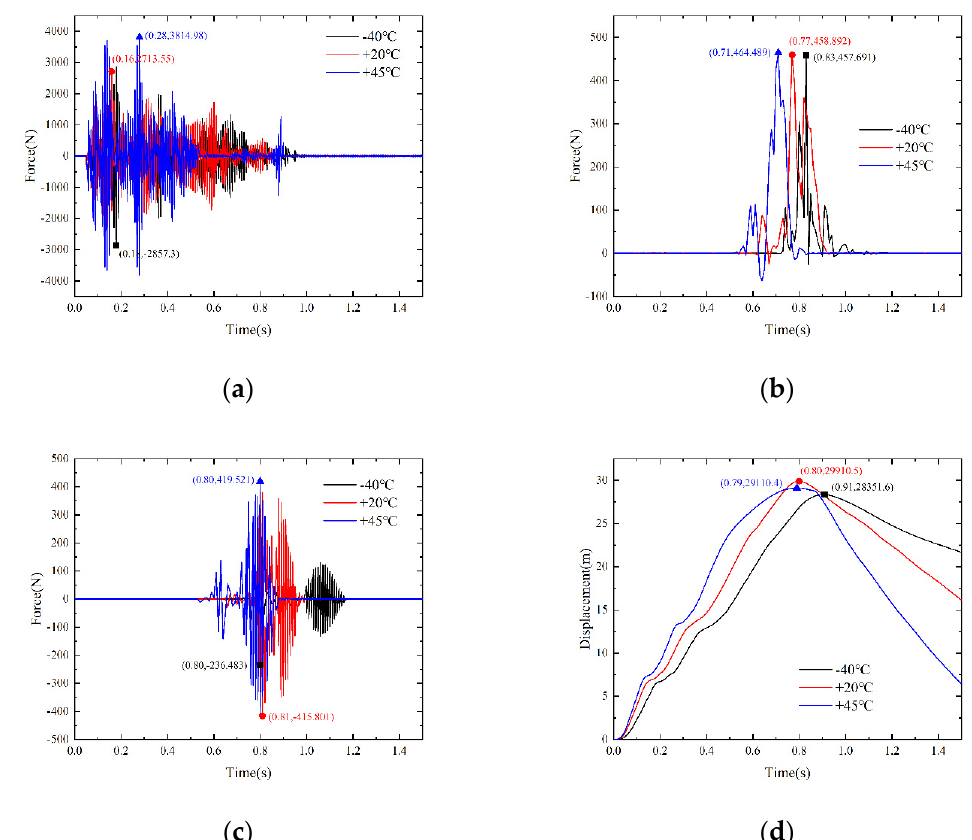
Figure 20. Deployment performance under different temperatures. ( a ) Extraction line force ( b ) Sling force ( c ) Suspension lines force ( d ) Tractor rocket displacement.